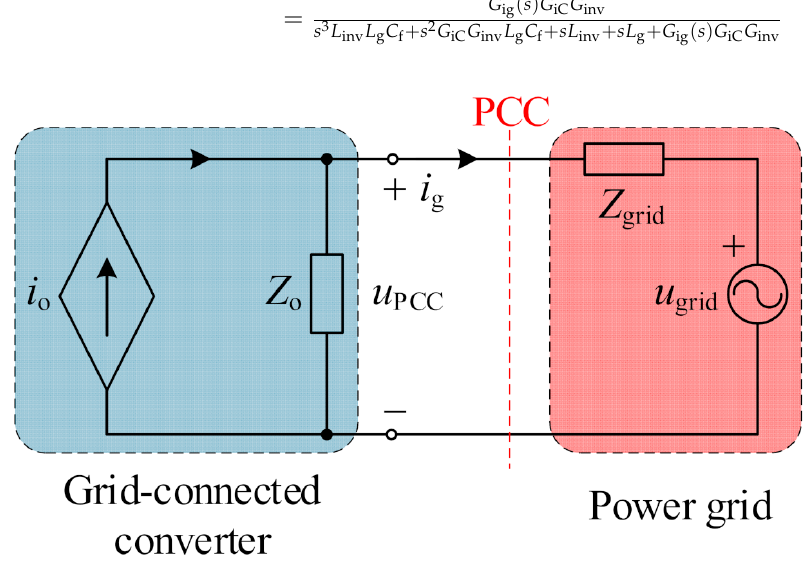
Figure 3. Norton equivalent circuit of grid-tie converter.